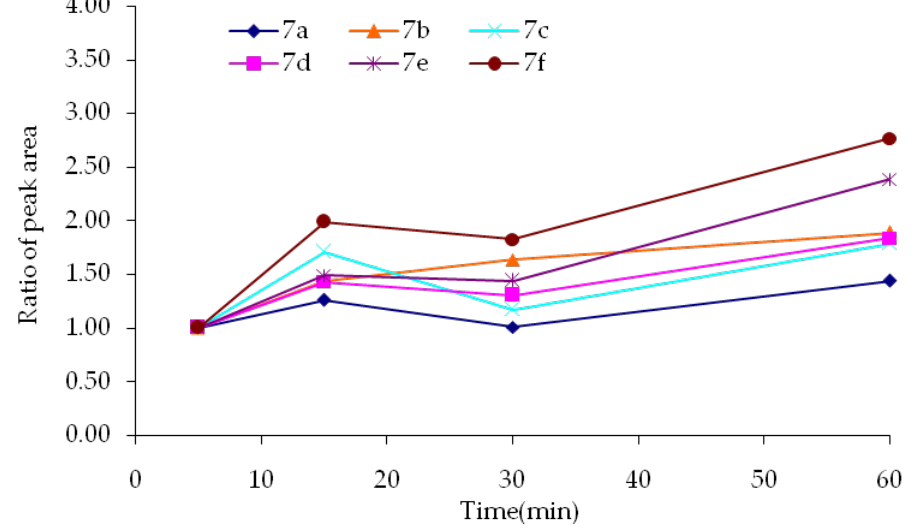
Figure 3. Deliverance of LCX001 by the prodrugs in brain homogenate. Figure 3. Deliverence of LCX001 by the prodrugs in brain